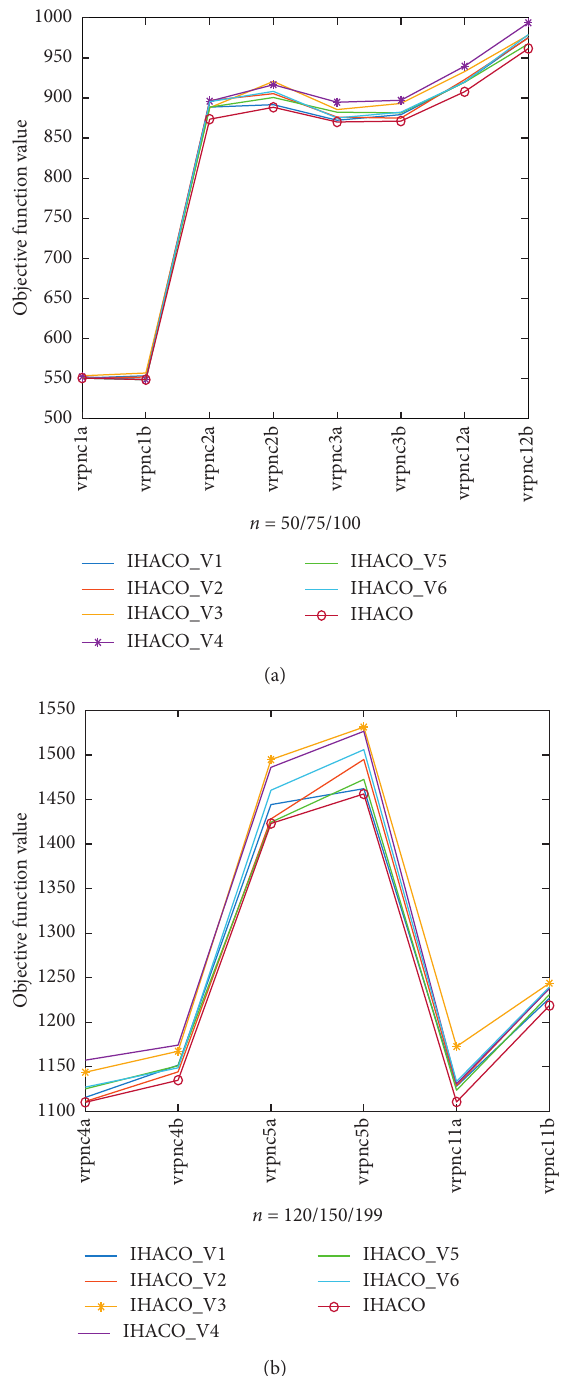
Figure 2: Comparison results of IHACO and its variants on different-scaled instances: (a) the customer scale is no more than 100; (b) the customer scale is greater than